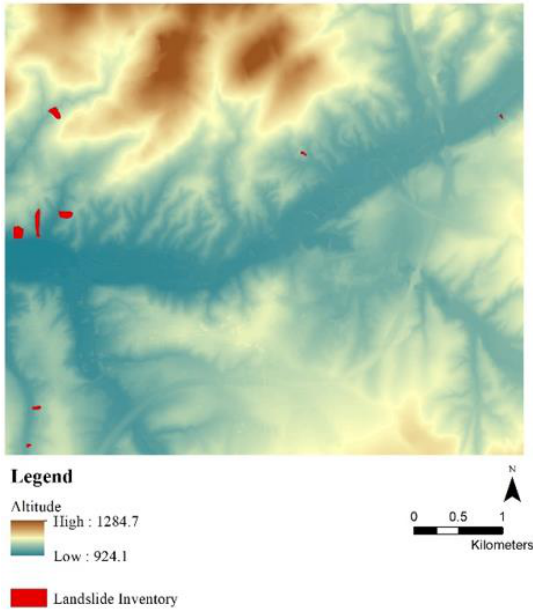
Figure 3. The altitude ranges and the landslide inventory in the study area. Figure 4. The slope gradient map of the study area The slope direction is the direction of the steepest descent line and is usually measured in degrees clockwise starting from the north. The ratio of landslides is determined on which slopes (north, south, etc.) are higher than the others (Wilson and Gallant, 2000). The aspect values represent 90° in North, 180° in West, 270° in South, and 360° in East. The aspect map of the study area is shown in Figure 5.